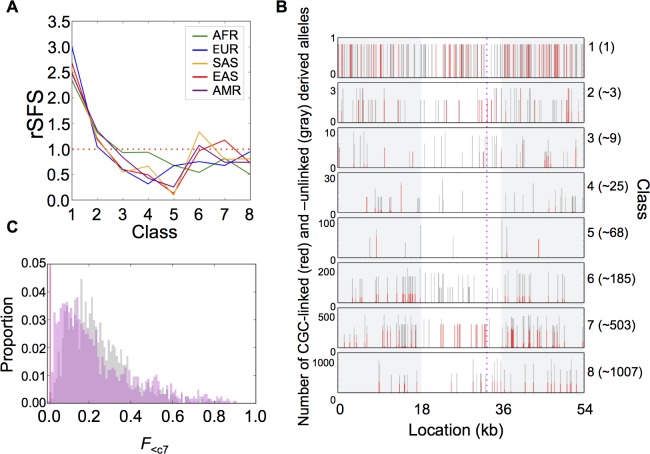
Site frequency spectrum and barcode representation.(A) Relative site frequency spectrum (rSFS) that is defined as the ratio of observed-to-expected proportion of SFS in the 54-kb region. The rSFS is calculated from D1000 and the expectation under the standard neutral model of constant size. (B) Barcode representation of SNPs in the 54-kb region of EAS. The red dotted line shows the location of the three promoter SNPs. A red bar and a gray bar at an individual SNP site indicate the number of derived alleles that are linked to the CGC-type and the nonCGC-type, respectively. The unshaded area corresponds to the 18-kb core LD region. (C) Simulated distributions of F<c7 under the standard model of constant size (1,237 replications in gray) and the demographic model of changing population size (1,259 replications in magenta; [17]). The red vertical line represents the observed F<c7 in EAS.